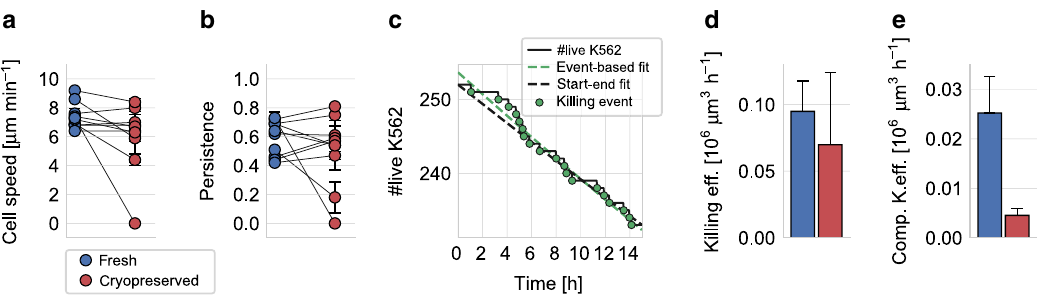
Fig. 4 NK cell migration and cytotoxicity in 3-D collagen gels. a Migration cell speed of fresh (blue) and cryopreserved (red) NK cells from n =